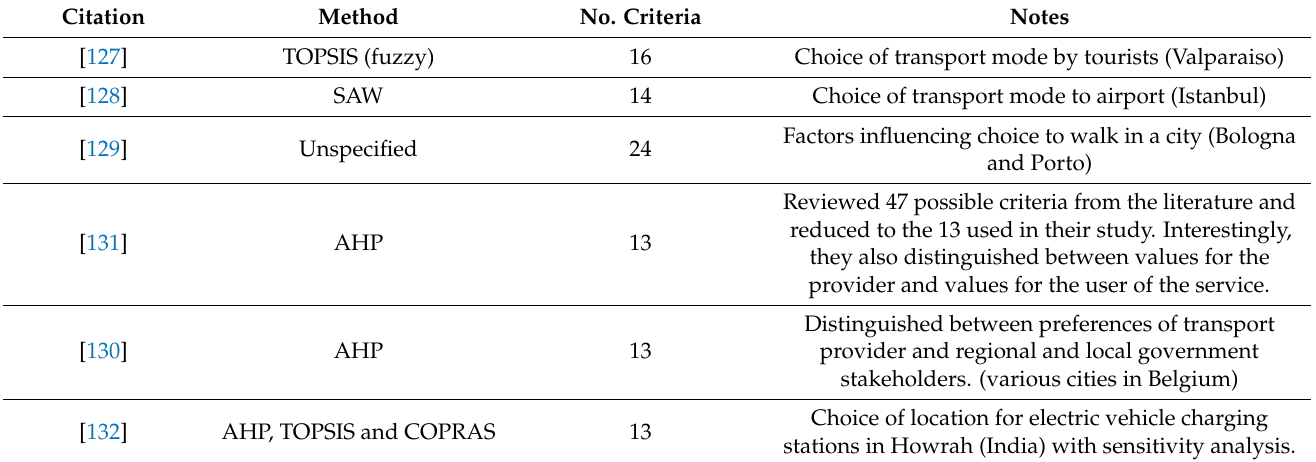
Table 11. Examples of applications of MCDA to Transport mode